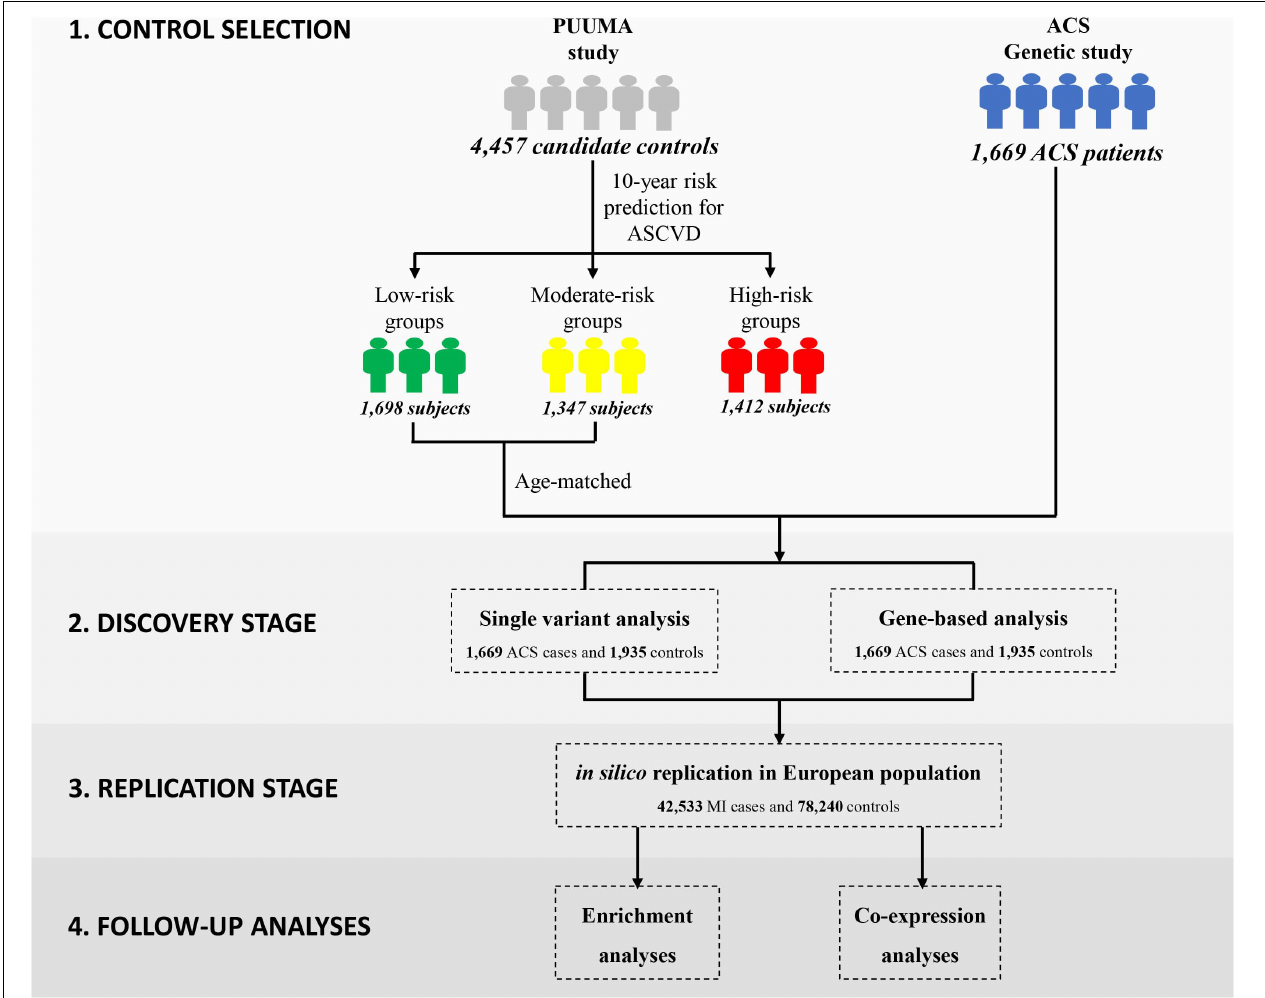
FIGURE 1 | Overview of the study design and statistical analysis